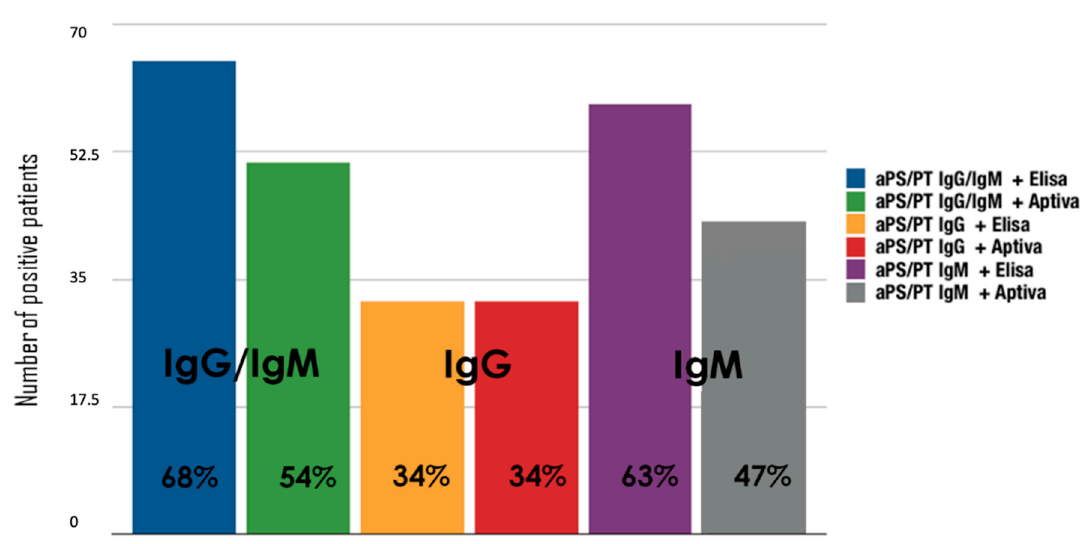
Figure 1. Number of positive patients with enzyme-linked immunosorbent assay (ELISA) and particle-based multi-analyte technology (PMAT) testing. aPS/PT means antiphosphatidylserine / prothrombin antibodies; ELISA, enzyme-linked immunosorbent assay.